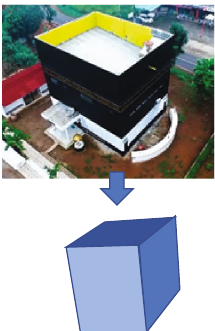
Figure 41: Construction building number ̂ 1